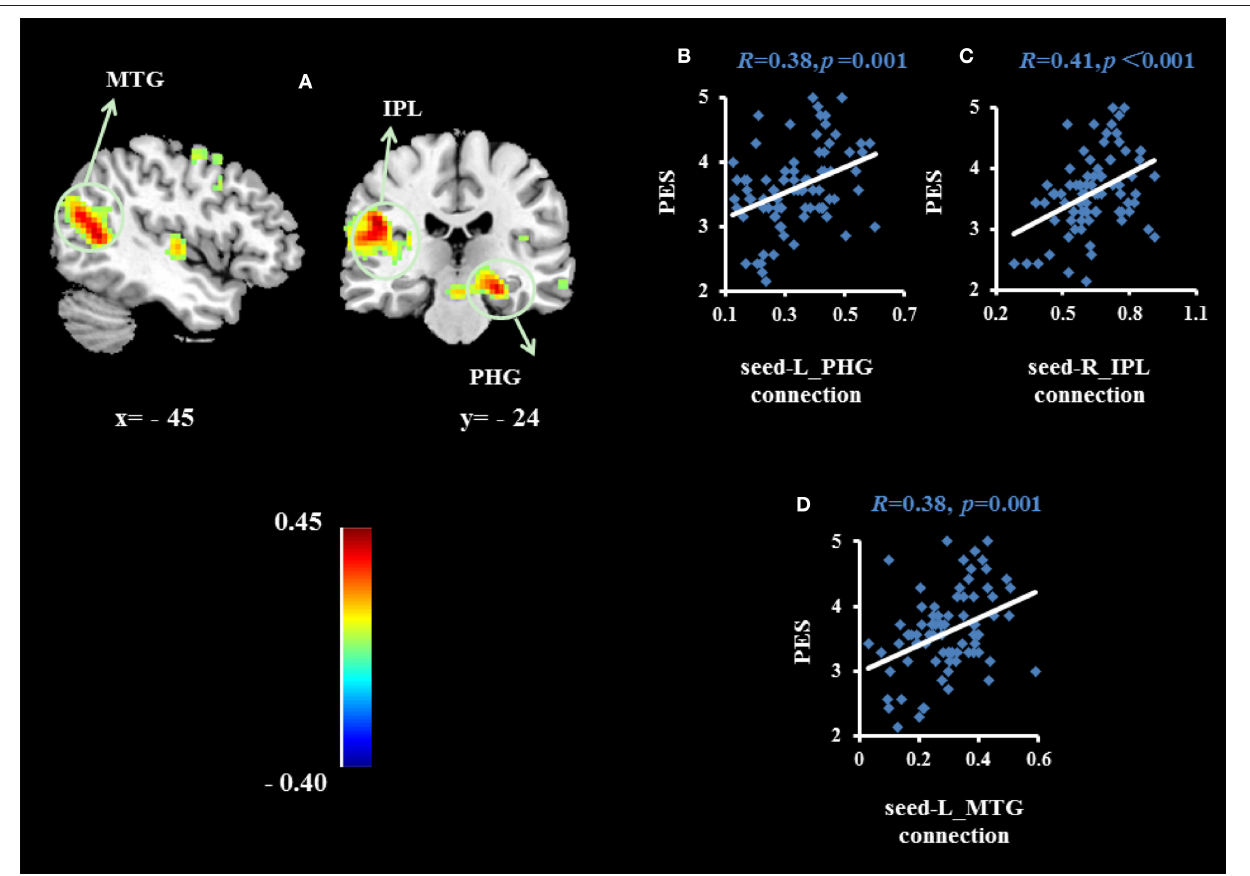
FIGURE 2 | Brain regions whose functional connectivity strengths with the right insula (seed) were significantly associated with the average score of PES (A) . The threshold of corrected cluster was set at P < 0.05 [single voxel P < 0.001, cluster size > 226 voxels, and 1000 iterations]. Color bars represent R-values. L = left, R = right. (B–D) indicate significant correlations between PES and functional connectivity strengths between the left parahippocampal gyrus (PHG), left inferior parietal lobule (IPL) and left middle temporal gyrus